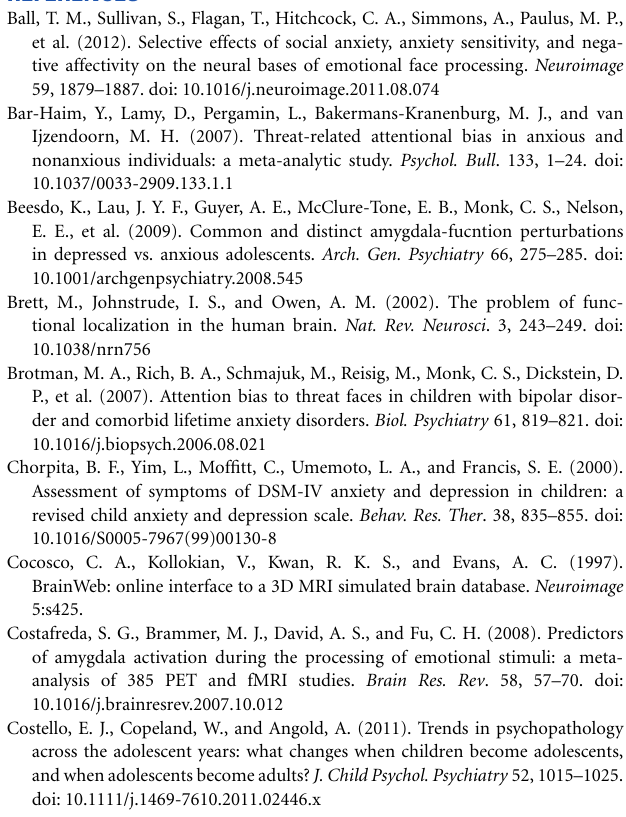
Table S1 | Whole brain activation patterns for the contrasts: (A) positive effect of condition; (B) fearful faces > fixation; (C) happy faces > fixation; (D) neutral faces > fixation; (E) fearful faces > neutral faces; and (F) happy faces > neutral faces. Coordinates represent significant peaks of activation at p < 0 . 05, FDR-corrected, 10 contiguous voxels and are listed in MNI space. ∗ p < 0 . 05 when corrected for multiple comparisons at cluster-level (FWE). Table S2 | Pearson correlations between anxiety (RCADS) and depression (CDI) subscale scores and parameter estimates of left and right amygdala ROI values for N = 22 adolescents from the clinical